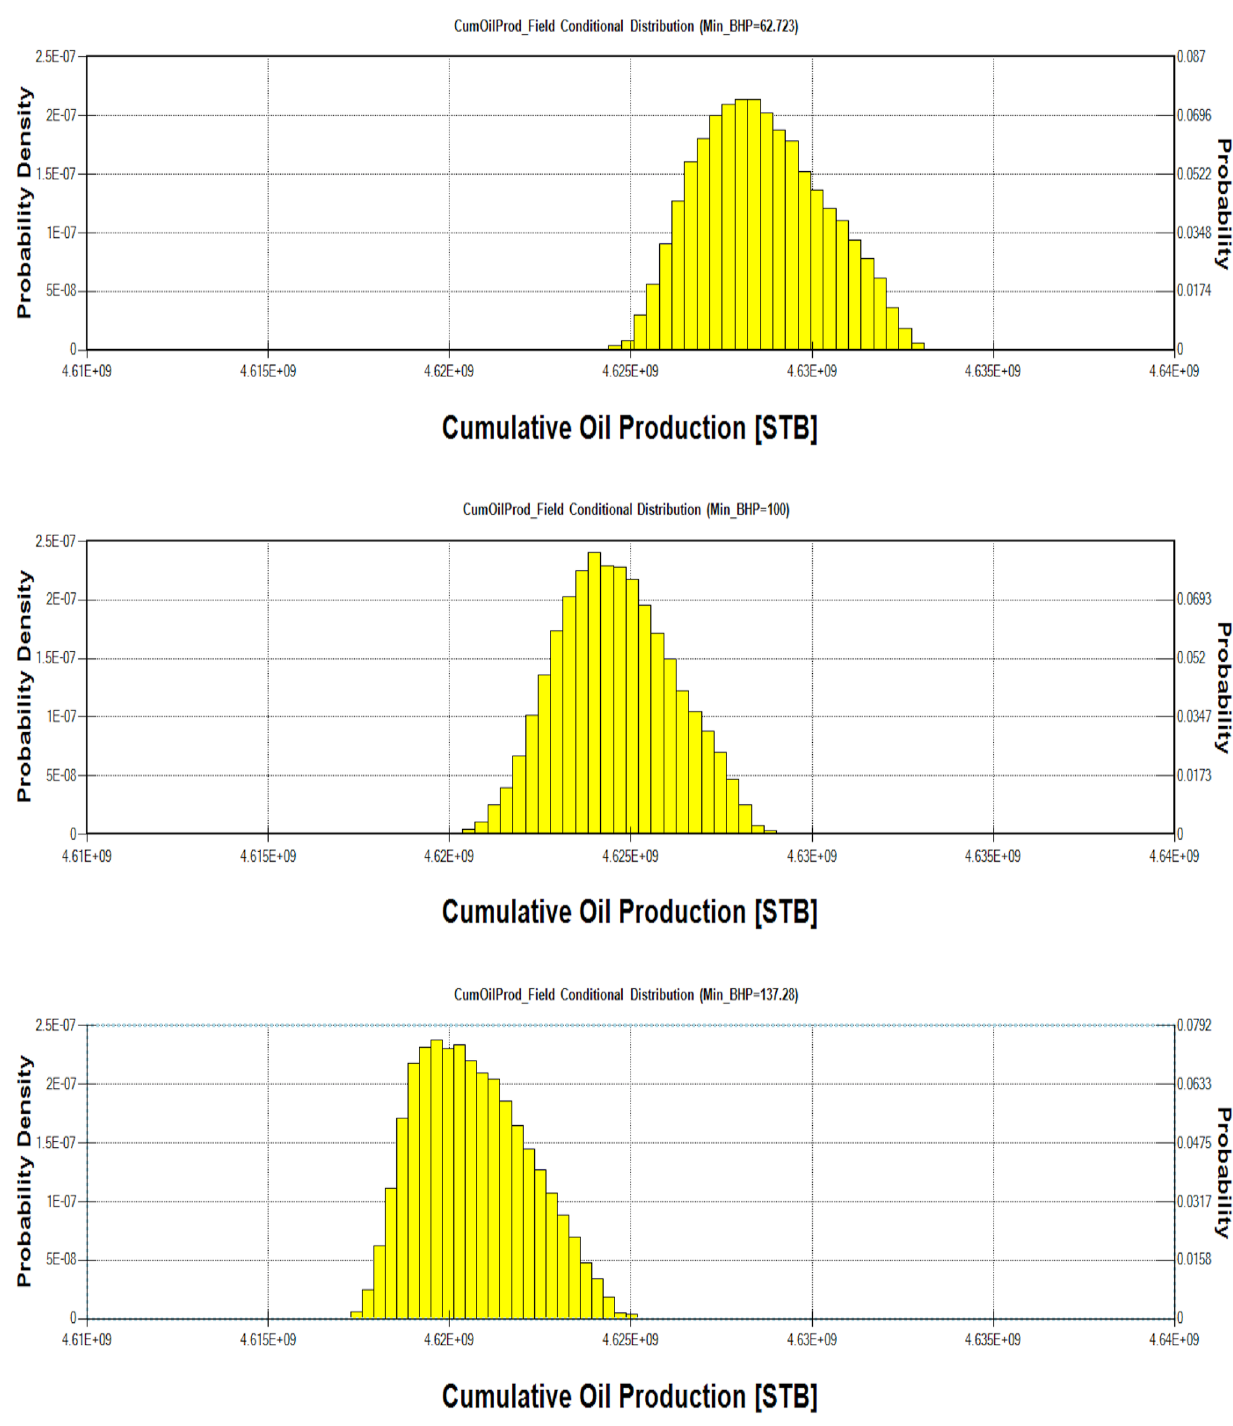
Fig. 22 Probability distribution of flow response as a function of minimum